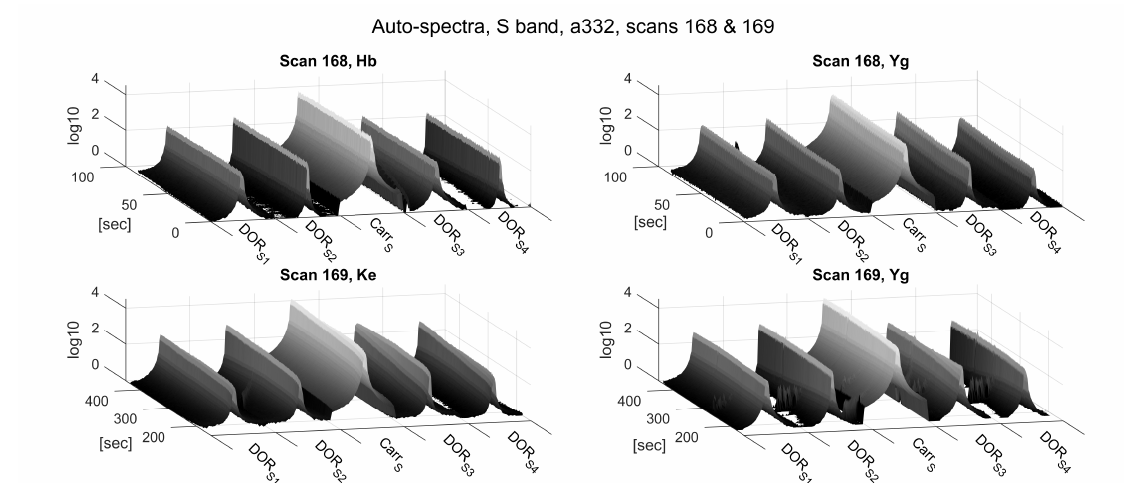
Figure 4. Auto-spectrum magnitudes of the S-band zoom-bands of Scans 168 (upper panels) and 169 (lower panels) of Experiment a332. The frequency axes (horizontal axes) depict the five 32 kHz wide DiFX zoom-bands described in Table 3 next to one another. The time axes indicate seconds since the start of Scan 168 (10:41:04